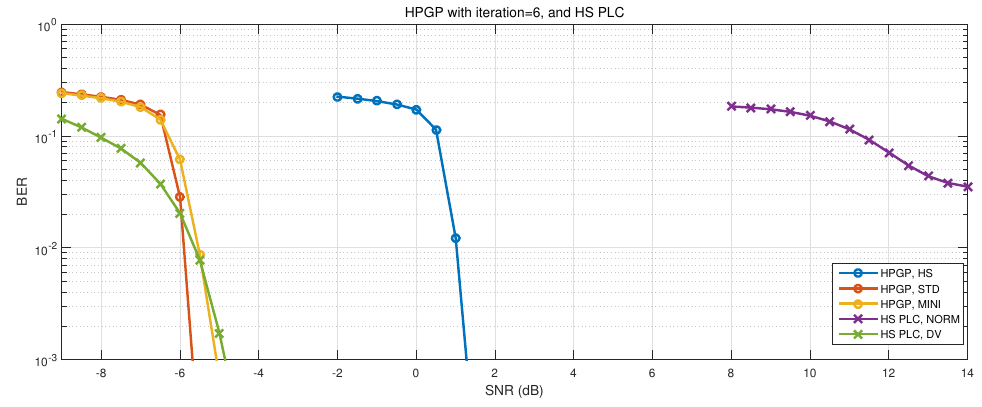
Figure 20. BER results of HPGP and HS